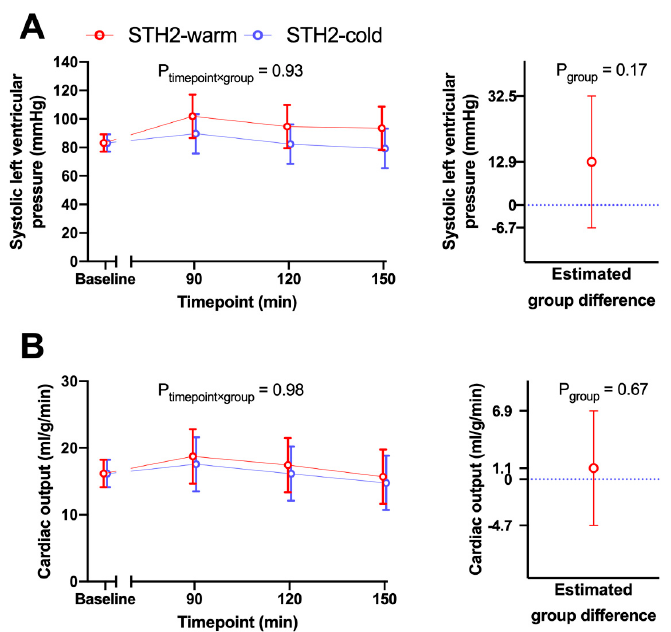
Figure 2. Left ventricular pressure and cardiac output. Haemodynamic data were recorded at baseline and every 30 min during off-pump reperfusion. Systolic left ventricular pressure ( A ) and cardiac output ( B ) were comparable in STH2-warm versus STH2-cold. Values are least square arithmetic means (left) or estimated mean group differences with 95% confidence intervals, n = 5–6/group.